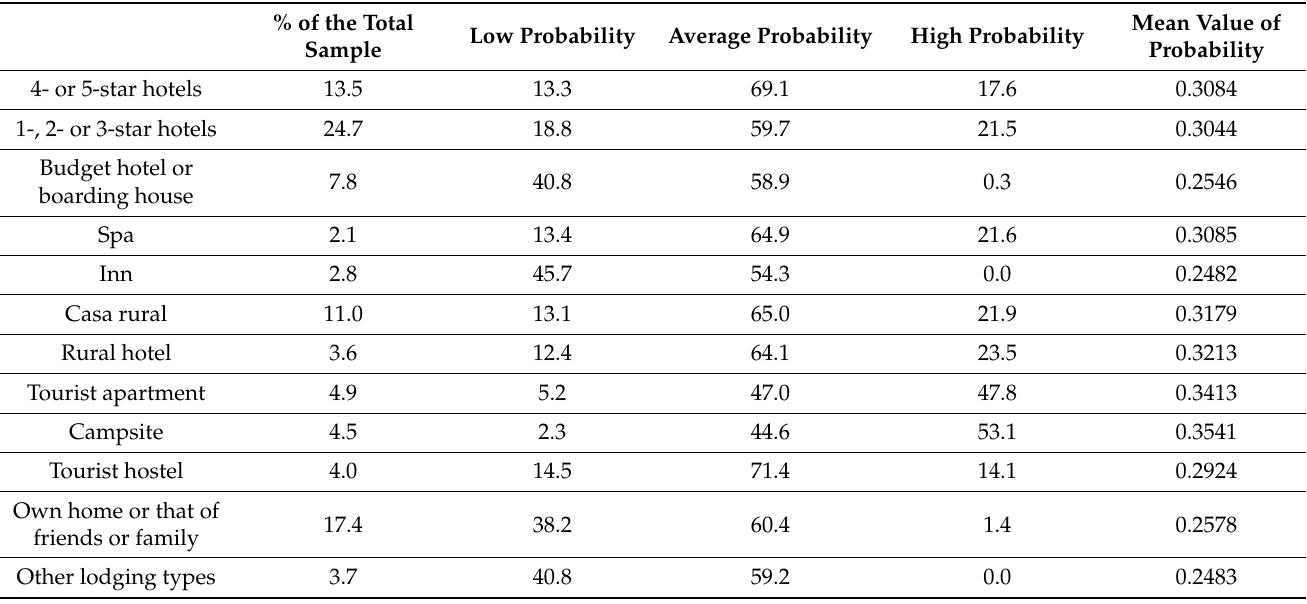
Table 6. Relationship between the type of lodging and the estimated probability of visiting the Monfragüe